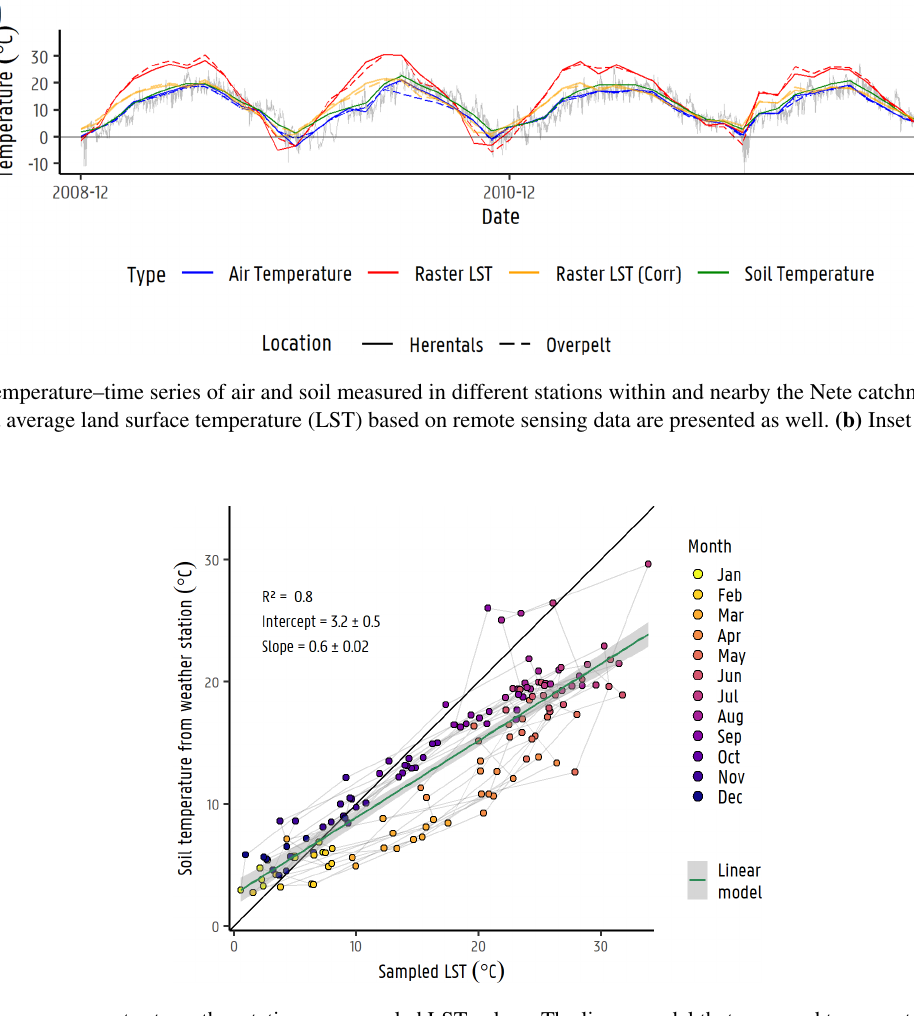
Figure A3. In situ measurements at weather stations vs. sampled LST values. The linear model that was used to correct raster LST values is